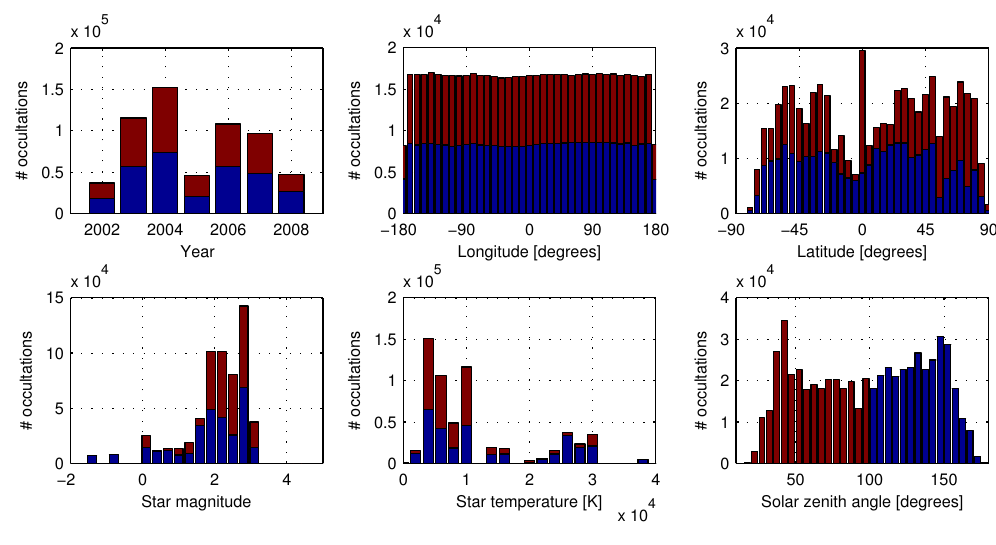
Fig. 1. Occultation statistics for the entire GOMOS data set spanning the period August 2002–May 2008. Shown are histograms representing the number of GOMOS occultations as function of (from left to right, top to bottom) year, longitude, latitude, star magnitude, star temperature and solar zenith angle. Blue histograms refer to the fraction of occultations in dark limb, red ones to the fraction in bright limb. ter sampling is obtained. The actual star spectrum is (in nor- mal mode)calculatedfrom7 CCD rows ofthe spectrometers, equivalent to a (cid:2)eld of view of 0.01 degrees. are calculated that in turn are used to derive altitude